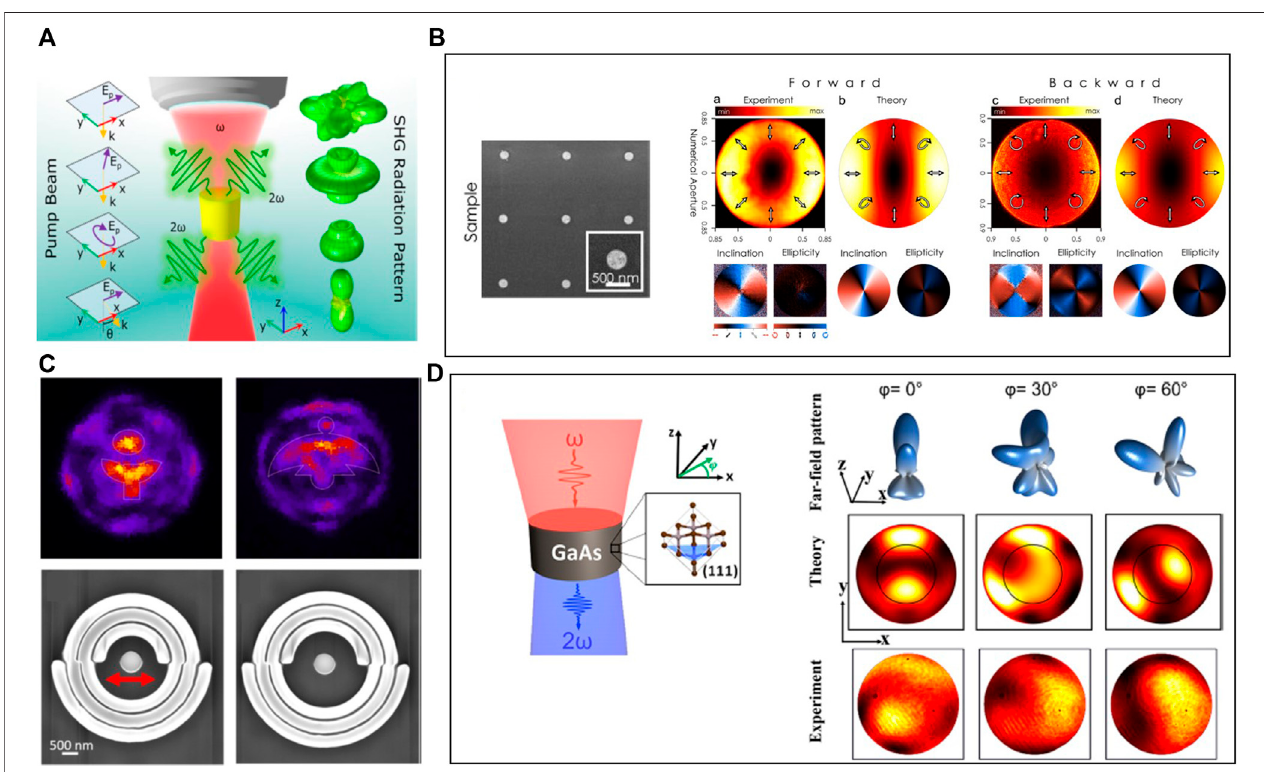
FIGURE 7 | Directionality and polarization control of SH signals in dielectric nanostructures. (A) Manipulation of the radiation pattern of THG from AlGaAs all- dielectricnanoantennasbythepump beampolarization, incidentangle (Carlettiet al.,2016). (B) SH fi eldscontrolofAlGaAs nanoresonators.Thedirectionalitydiagrams in forward and backward directions, and the polarization inclination angles and ellipticity for the directionality cases (Camacho-Morales et al., 2016). (C) SHG far- fi elds resembling a fl ower and a bird obtained with a single AlGaAs nanodisk antenna using coplanar holographic gratings with d = 450 nm and d = 700 nm (Ghirardini et al., 2018). (D) SHG from a (111)-GaAs nanodisk for different pump polarizations. The simulated radiation patterns and the theoretical and measured back-focal plane (BFP) images in the forward direction (Sautter et al.,